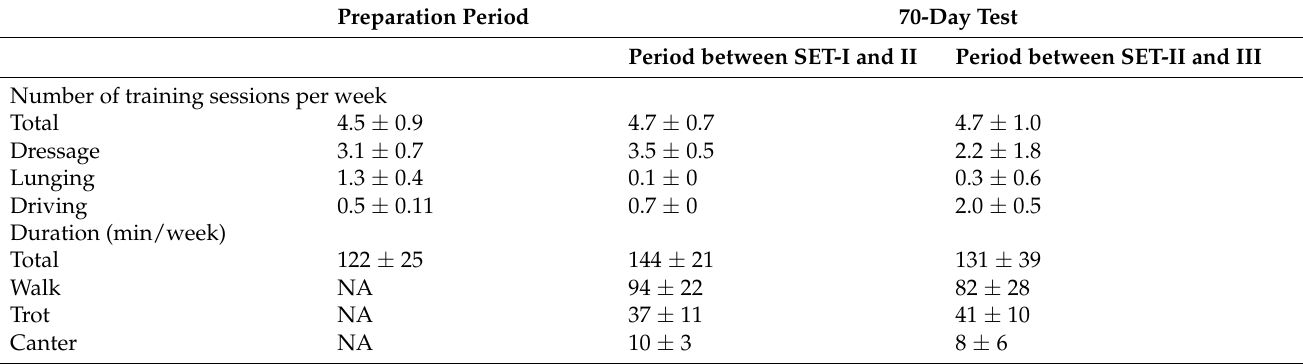
Table 3. External workload (duration and number of training sessions) per type, gait and per week of young Friesian stallions during the preparation period ( n = 9 weeks) and the 70-day test. NA = not